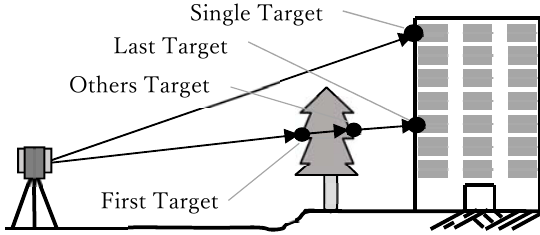
Figure2. Reflection signal classification image